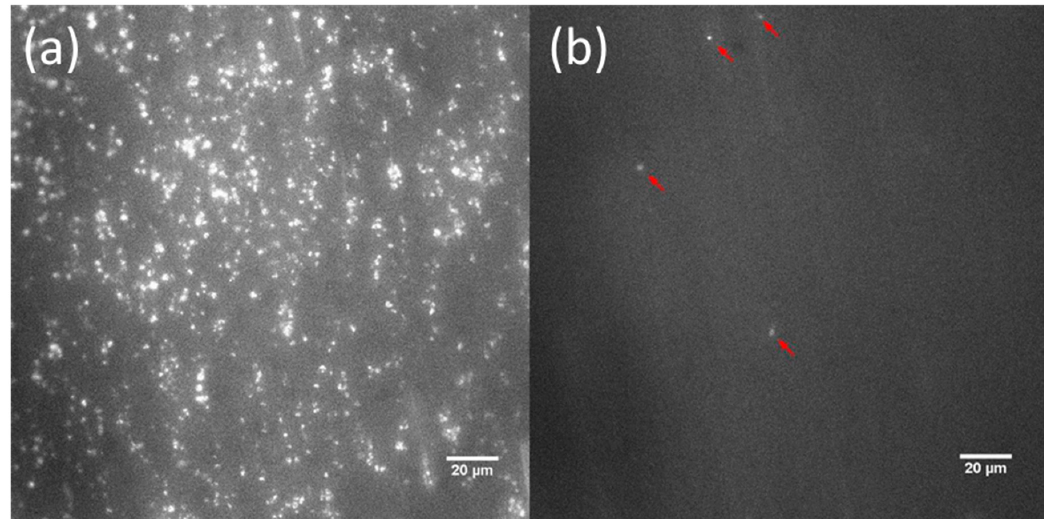
Figure 5. Representative images after 20 min blood perfusion at 600 s − 1 shear rate showing platelet aggregation on bare ( a ) and MEG-OH-modified 316L stainless steel ( b ).